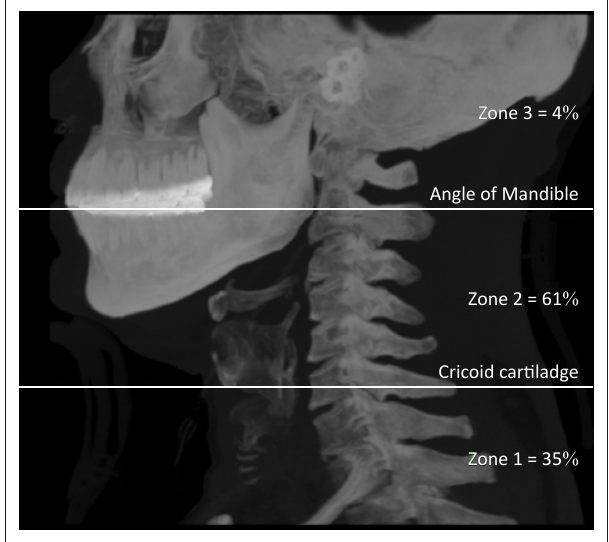
FIGURE 1: Anatomical zones and percentage